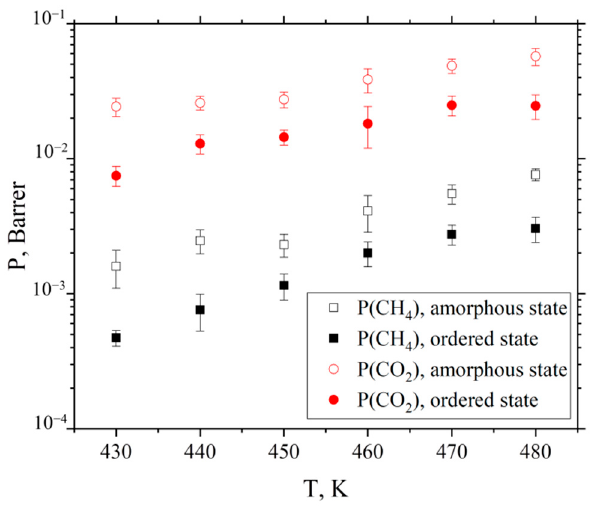
Figure 9. Temperature dependence of CH 4 and CO 2 permeability P of BPDA-P3 in amorphous and ordered states.